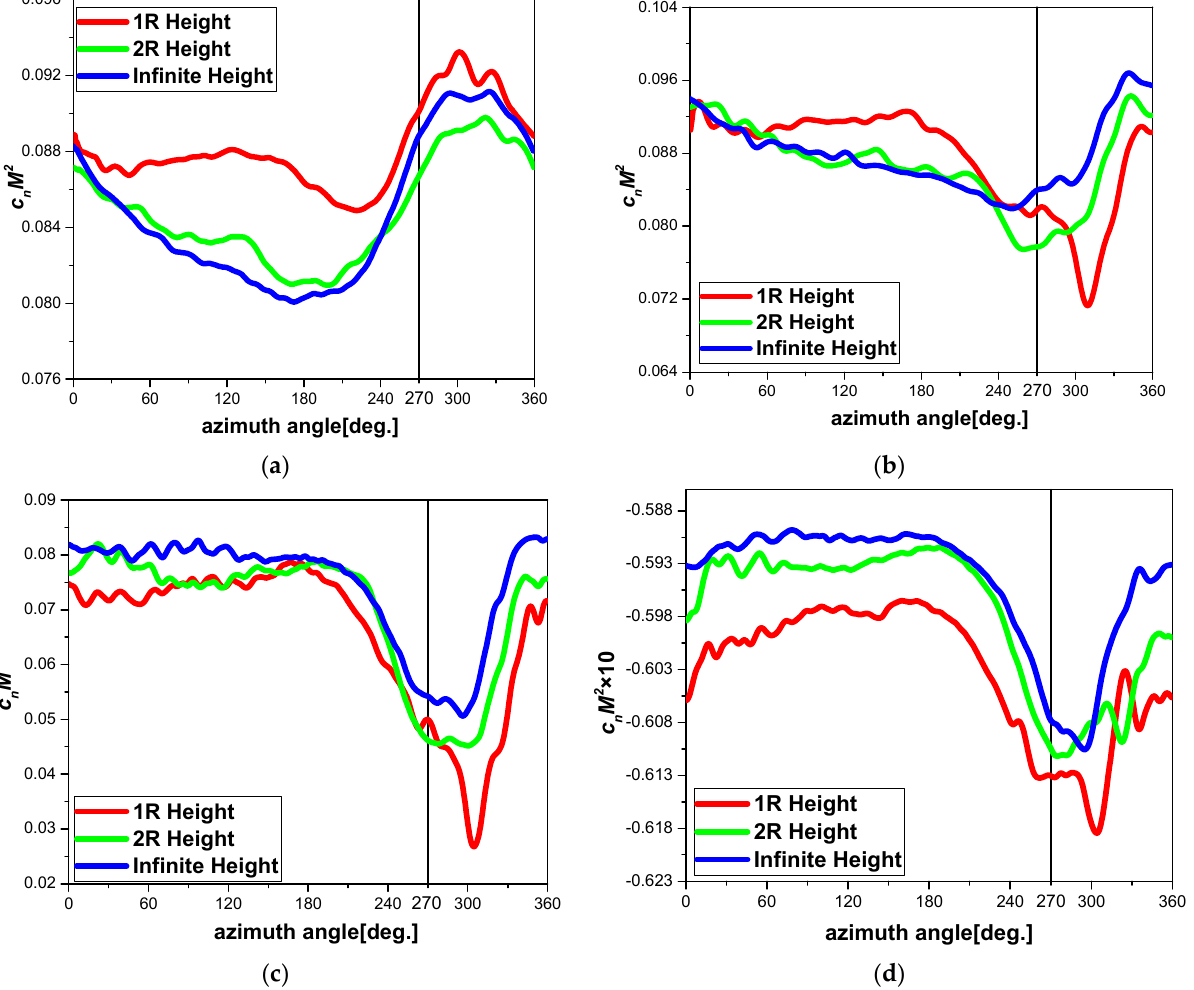
Figure 13. Normal force coefficient at different heights. ( a ) r/R = 0.5. ( b ) r/R = 0.7. ( c ) r/R = 0.8. ( d ) r/R = 0.95.